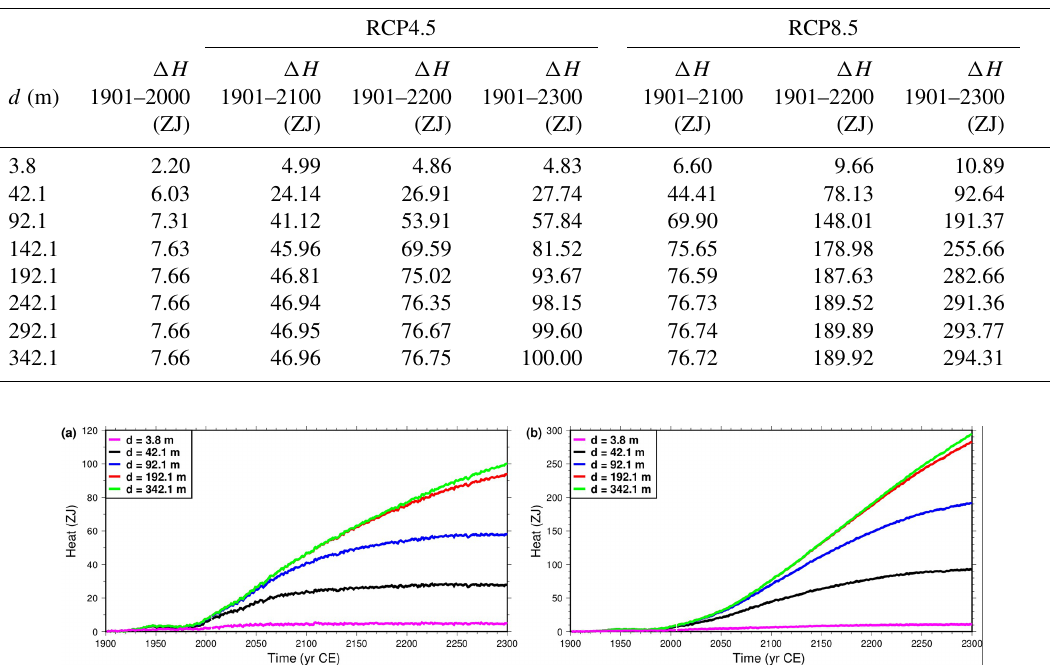
Table 1. Heat stored in the subsurface since 1901CE for the years 2000, 2100, 2200 and 2300CE for the RCP4.5 and RCP8.5 scenarios.